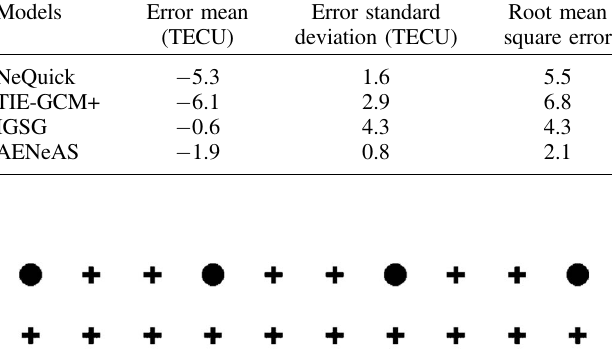
Table 2. Overall statistics of the model test for June 4th – 7th, 2017. Models